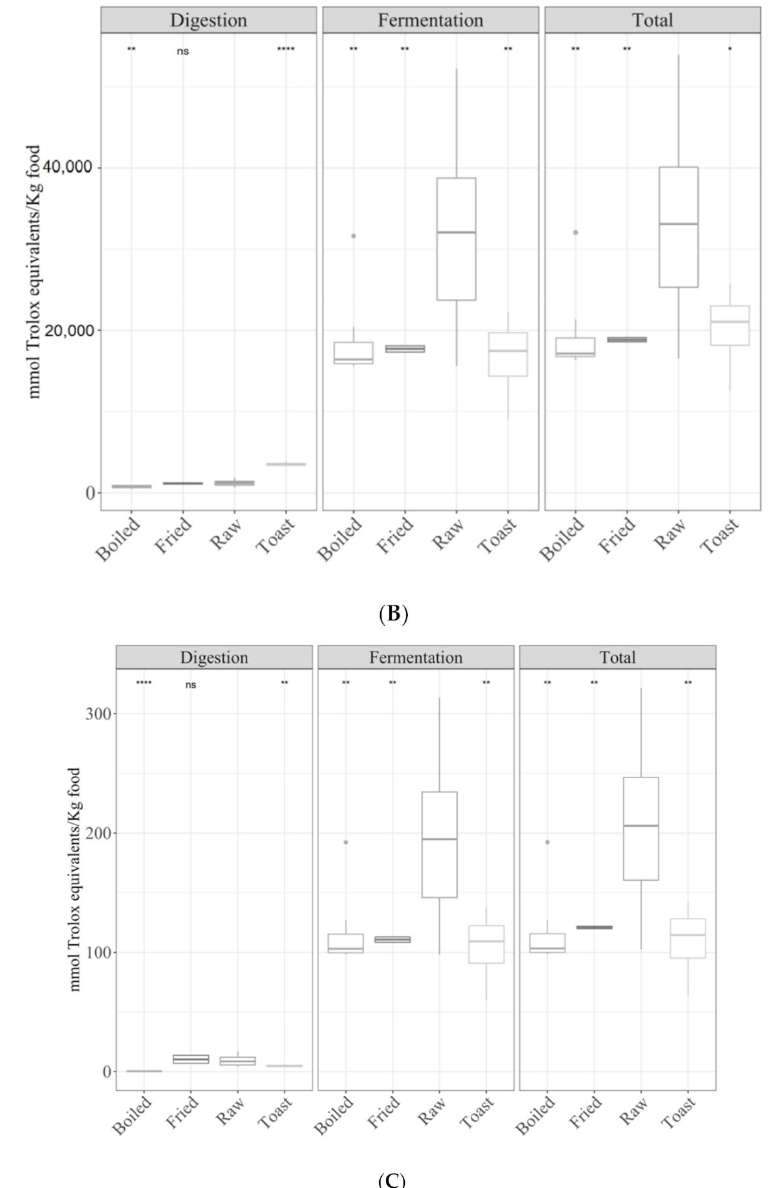
Figure 4. Antioxidant capacity of digested-fermented cereals depending on the type of cooking technique (( A ) TEAC DPPH , ( B ) Folin–Ciocalteu and ( C ) TEAC FRAP ). Statistical analysis was performed via ANOVA using raw cereals as the reference group. Statistic labels: *: p < 0.05, **: p < 0.01, ***: p < 0.001, ****: p < 0.0001, ns: not significant. On the other hand, when samples were compared, depending on the type of cereal-based food, they behaved similarly irrespective of the antioxidant assay (Figure 5A–C). For the digested fraction, biscuits were more antioxidant ( p < 0.05) than the other foods. However, for the fermented fraction and total antioxidant capacity, the following order was obtained: biscuits = breakfast cereals > bread = rice = pasta. Comparisons were also made between refined and whole-grain cereal products, but no significant di ff erences were